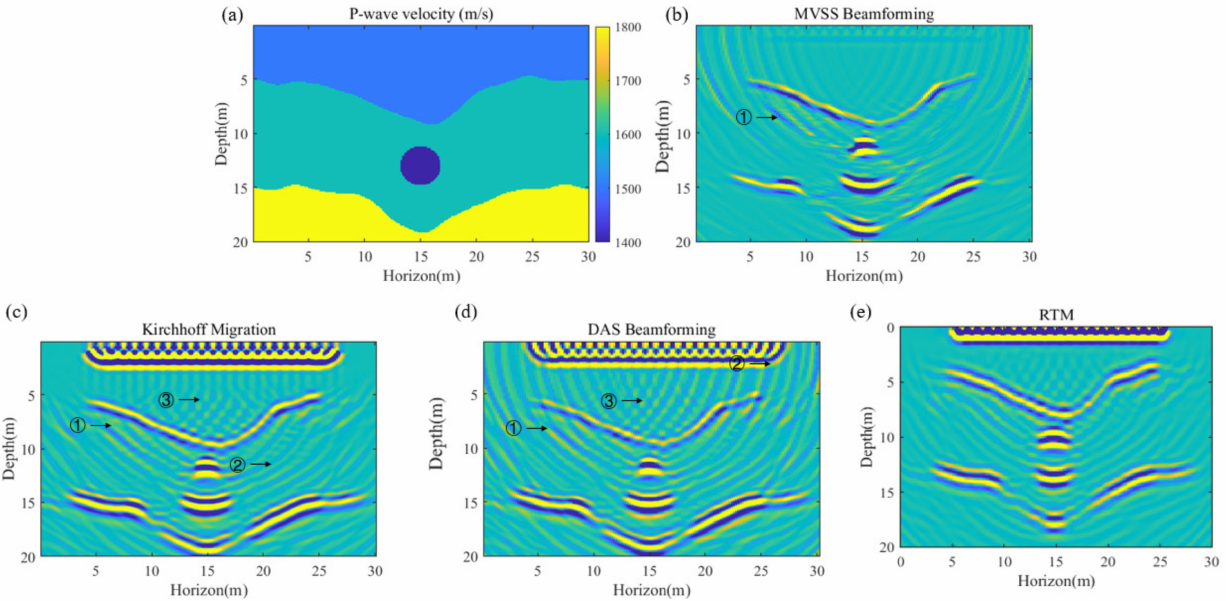
Figure 17. Model C-1. ( a ) True velocity model. ( b ) Imaging result of MVSS beamforming. ( c ) Imaging result of Kirchhoff migration. ( d ) Imaging result of DAS beamforming. ( e ) Imaging result of